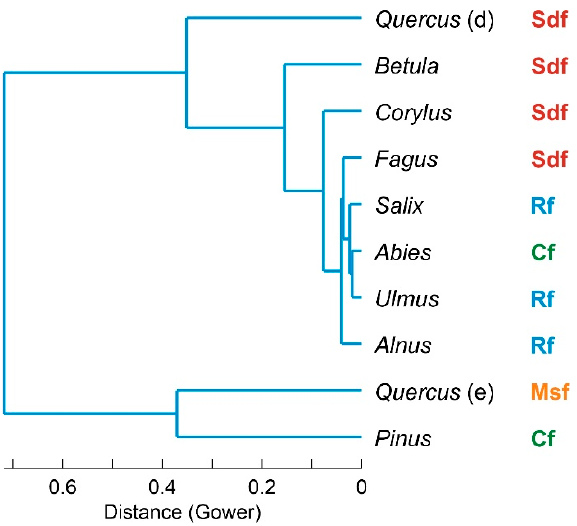
Figure 5. Cluster analysis using the Gower distance and the unweighted pair-group average (UPGMA) algorithm. Present-day forest types are indicated on the right and differentiated by colors: Cf, conifer forest; Msf, Mediterranean sclerophyll forest; Sdf, submontane deciduous forest; Rf, riverine forest.